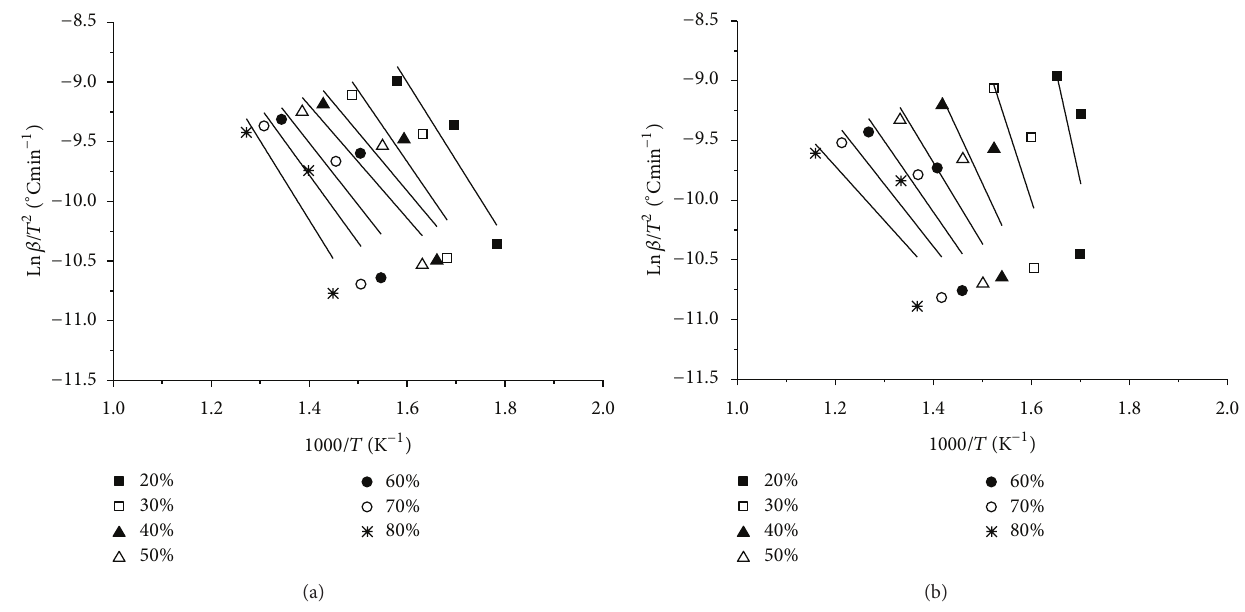
Figure 3: Isoconversional determination of the kinetic parameters based on the KAS method for (a) low CaO and (b) high CaO lignite